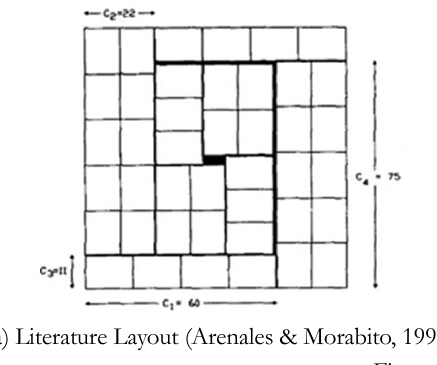
Figure 7. Layouts of Instance